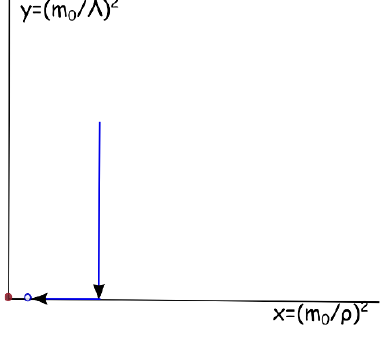
Figure 5 . The sudden